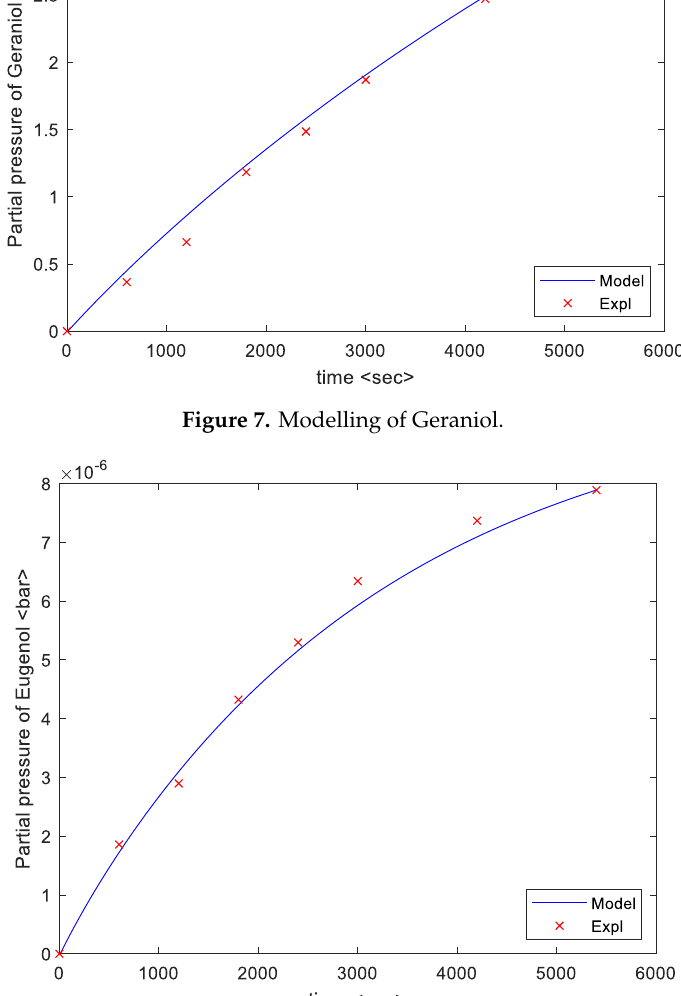
Figure 8. Modelling of Eugenol. Table 1. Values of the predicted convective mass transfer (k) and diffusion coefficients (D). Components